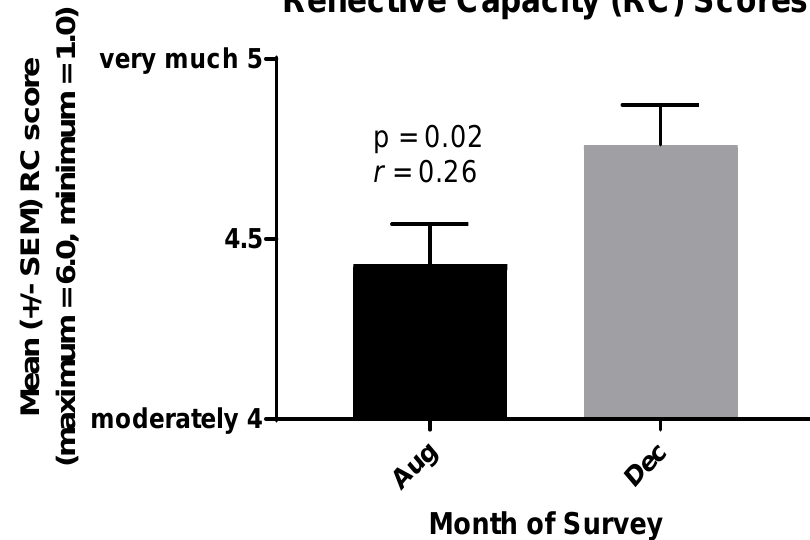
Figure 1. Increase in reflective capacity scores of prospective medical (MSBS) students in association with written reflections on service learning between August and December 2019. The mean response of MSBS students increased from closer to “moderately” in August to nearer “very much” in December for 16 statements concerning self-reported reflection.